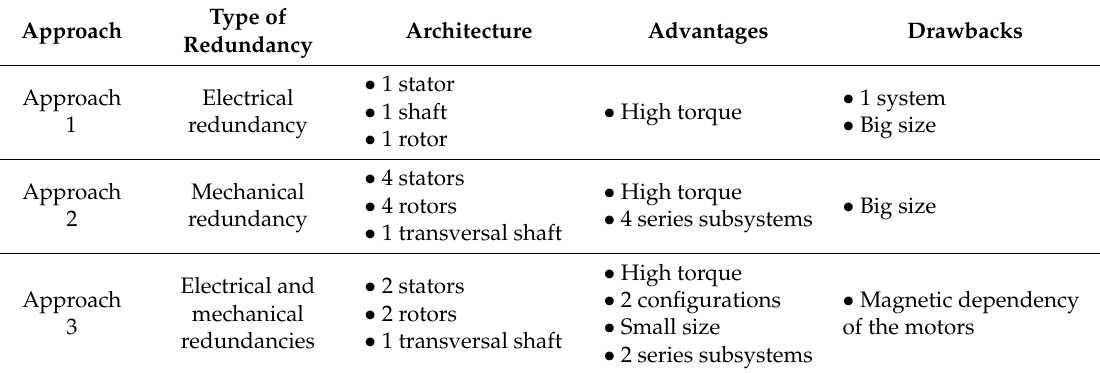
Table 2. Approaches of redundancy.